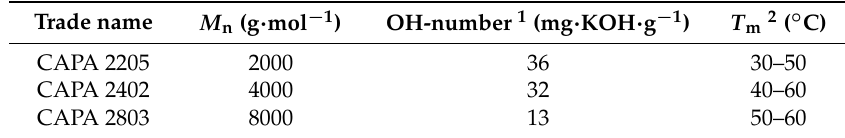
Table 1. Properties of poly( ε -caprolactone) diols used for foam